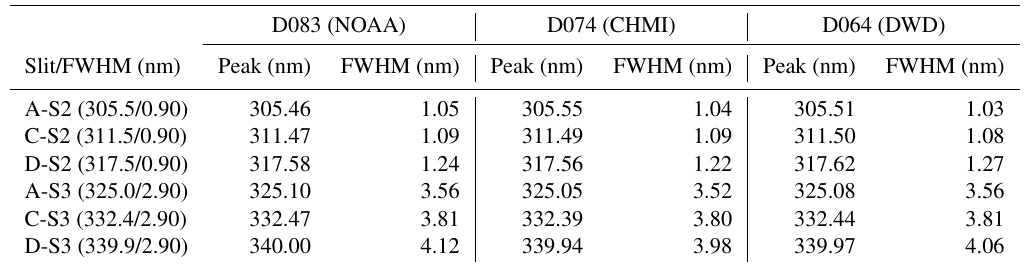
Figure 7. Slit functions at the long wavelength of wavelength pair A (A-S3) of all three reference Dobsons. Table 1. Measured centroid wavelengths (peak) and FWHMs (full width at half maximum) for all Dobsons and wavelengths; nominal values are given in the first column in